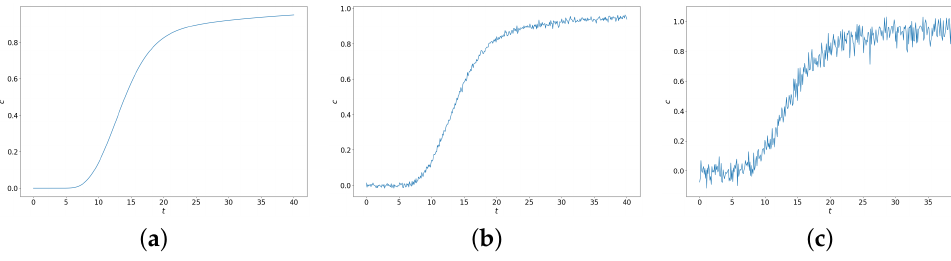
Figure 2. Breakthrough curves of synthetic experimental measurements: ( a ) without noise, ( b ) with random noise with variance σ 2 = 0.01, ( c ) with random noise with variance σ 2 =